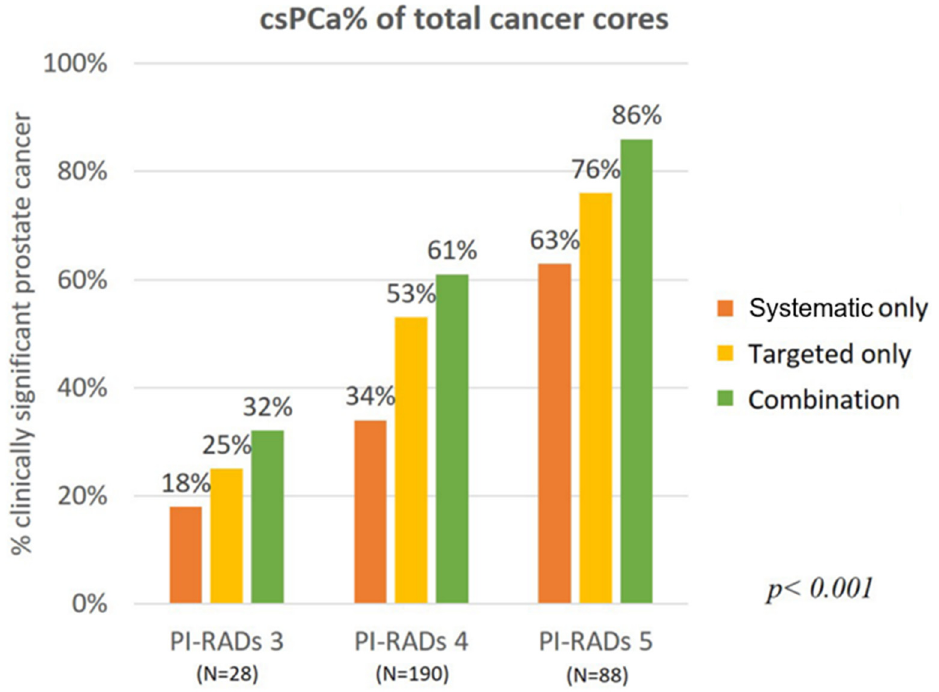
Figure 3. Clinically significant prostate cancer (csPCa) rate (csPCa/total cancer core) based on the PI ‐ RADS score. PI-RADS